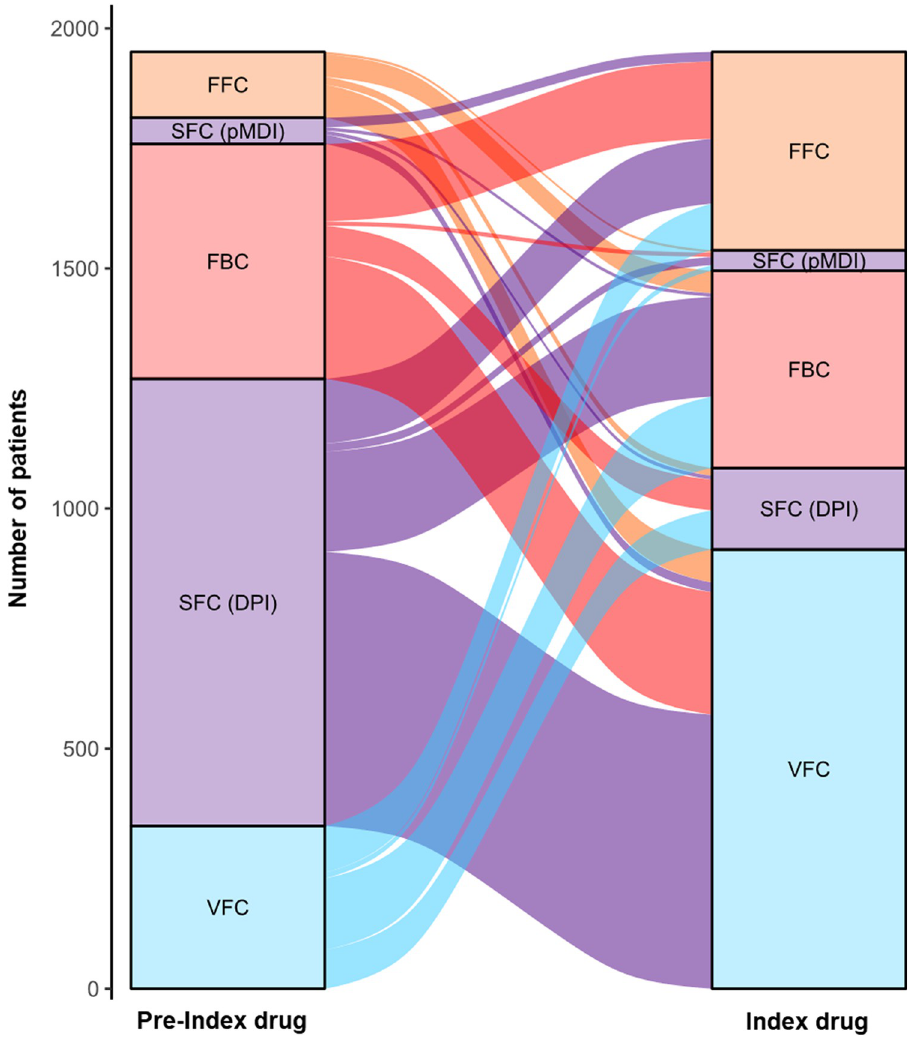
Fig 3. Switching patterns of ICS/LABA. FBC, formoterol/budesonide; FFC, formoterol/fluticasone propionate; SFC, salmeterol/fluticasone propionate; VFC, vilanterol/fluticasone furoate; DPI, dry powder inhaler; pMDI, pressurized metered-dose